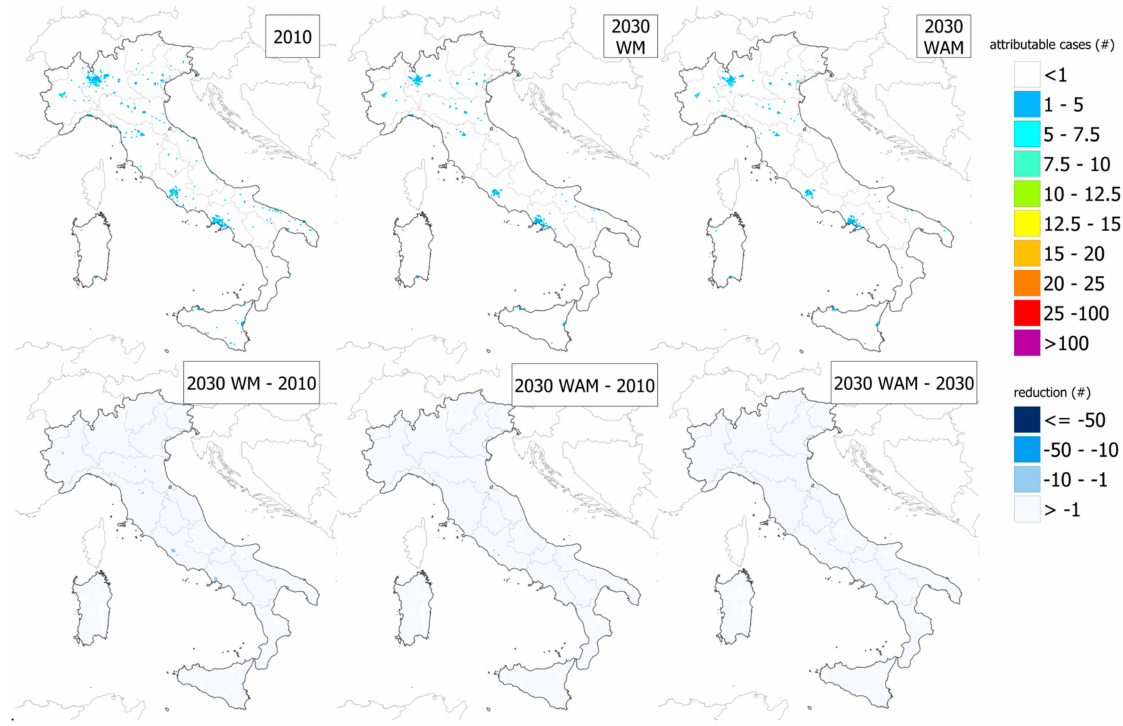
Figure 3. O 3 mortality (number of deaths) in 2010 ( upper left ), 2030 WM ( upper center ), 2030 WAM ( upper right ), variation in mortality between 2010 and 2030 WM ( lower left ), 2010 and 2030 WAM ( lower center ), and 2030 WM and 2030 WAM ( lower right